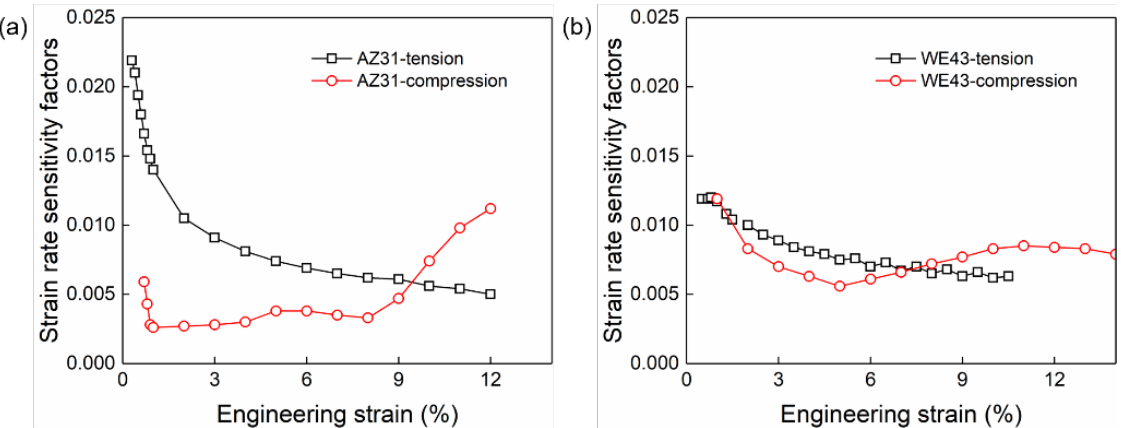
Figure 5. Strain rate sensitivity factors for the ( a ) AZ31 and ( b ) WE43 alloys under uniaxial tension and compression. ( a ) The SRS factor, 𝑚 , decreased dramatically for AZ31 tension as the strain increased, but for compression, the low SRS with 𝑚 value approached zero at low strain. Then, the sample exhibited strain rate dependence at higher imposed strains, which is caused by more slip systems activated and the dislocation movement. ( b ) The trend of the SRS factor of the WE43 alloy was similar to the AZ31 alloy, dropping from 0.012 to 0.006 under tension. This showed that the materials proved a positive SRS due to slip-dominated deformation. For the compression, the m value decreased firstly at the low strain regime and then arose slowly at the high strain regime, which is caused by slip deformation and twin behavior occurring simultaneously and affecting each other.